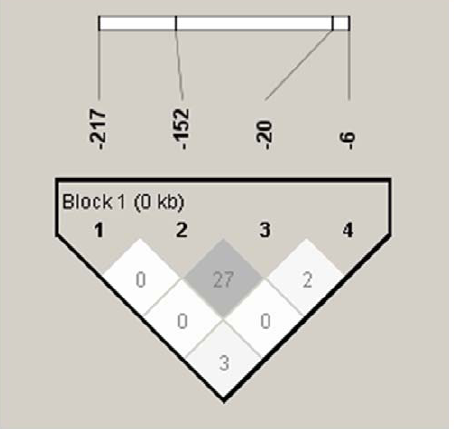
Figure 3. Linkage disequilibrium plot of AGT promoter polymorphisms. Pairwise linkage disequilibrium analysis shows r 2 ( 6 100) values. The intensity of gray is proportional to r 2 .